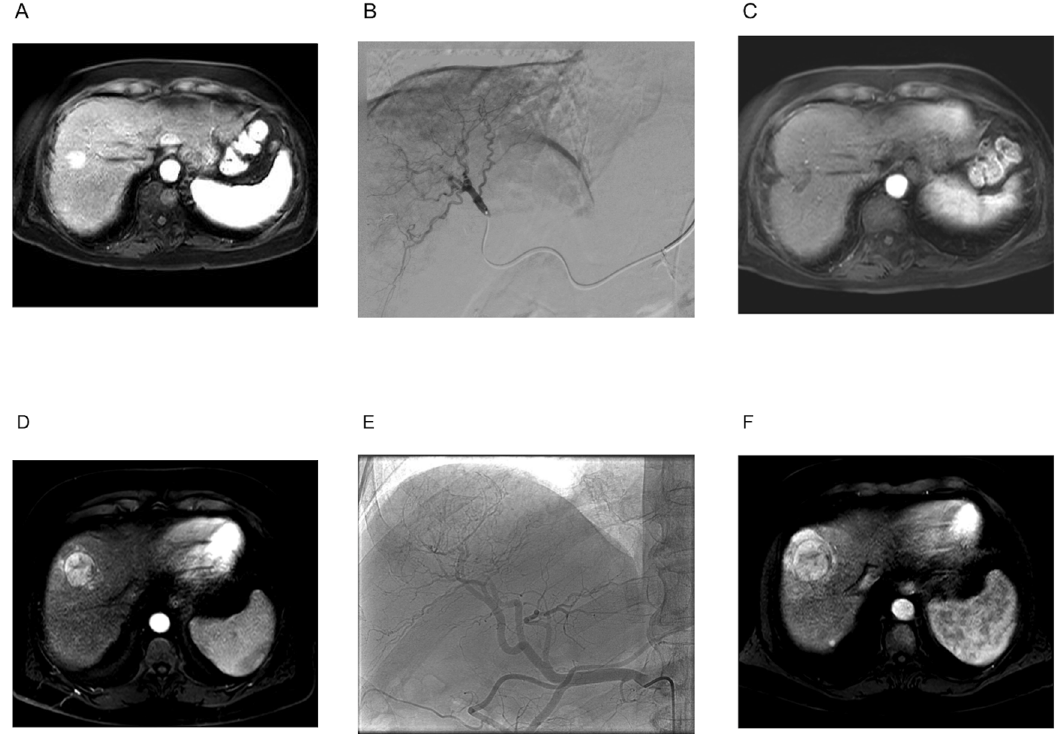
Fig 2. Example magnetic resonance imaging before and after local ablative therapy. A) MRI of an HCC before treatment of a responding patient. HCC shows contrast enhancement in T1 sequence (arrow). B) Angiography image taken during TACE. HCC lesion is pooling arterial flow (arrow). C) Follow-up MRI of the responder patient. The lesion only shows ablation lesion after RFA/ TACE without contrast enhancement. D) MRI of an HCC before treatment of a non-responding patient. HCC shows contrast enhancement in T1 sequence (arrow). E) Angiography image taken during TACE. HCC lesion is pooling arterial flow (arrow). F) Follow-up MRI of the responder patient. The contrast-enhancing lesion shows increase in size